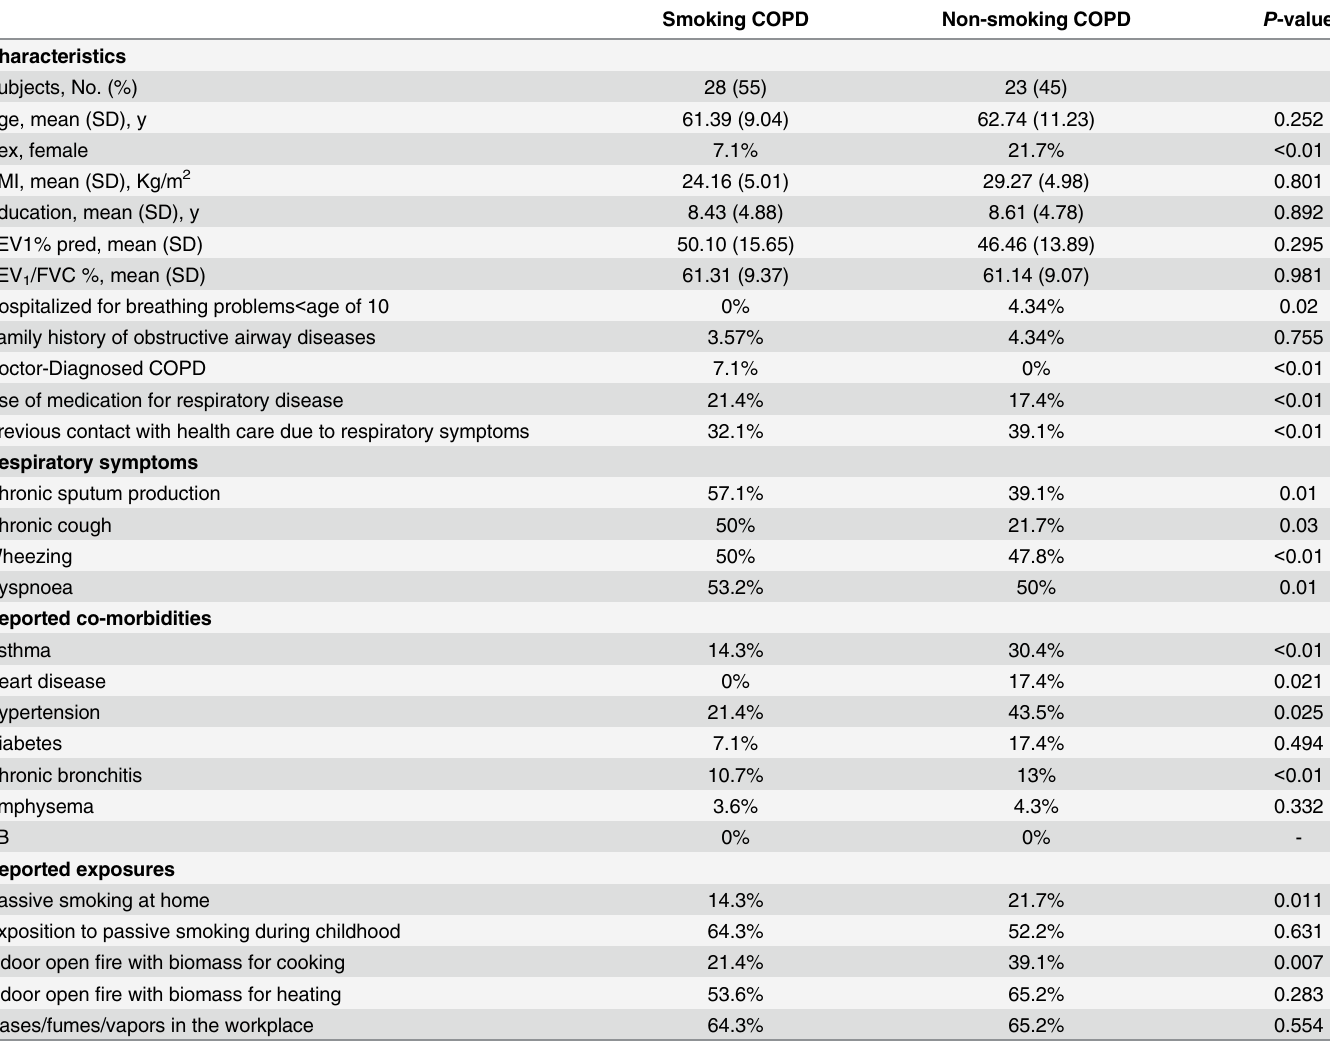
Table 3. Characteristics of chronic obstructive pulmonary disease (COPD) among nonsmokers compared with those in